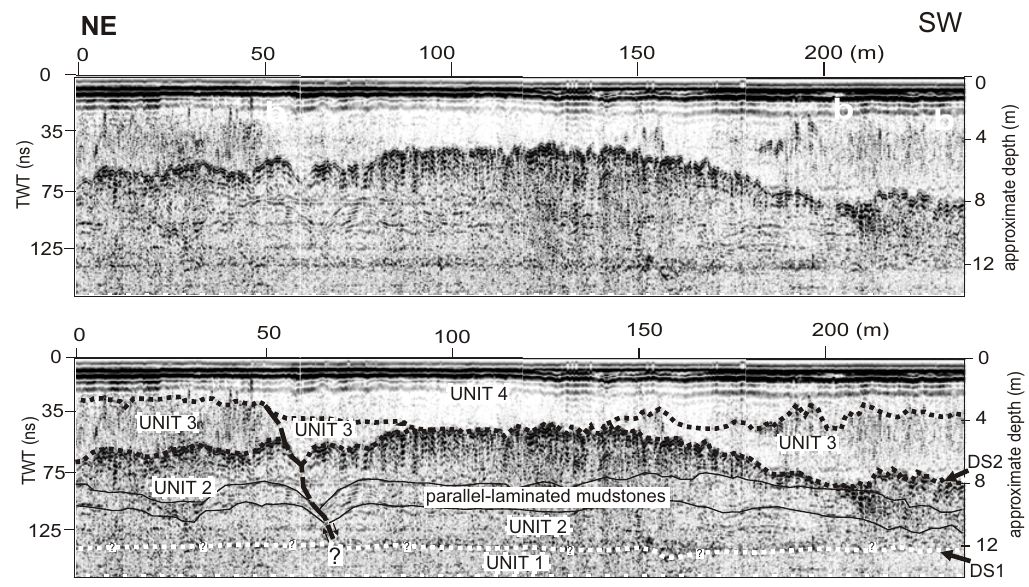
Fig. 4 – Non-annotated (upper) and annotated (lower) GPR section from the Outeiro Island area, illustrating four stratigraphic units (units 1 to 4) bounded by unconformities (hatched lines) that are locally displaced by a steeply-dipping normal fault (inclined black line). Note the drag of parallel reflections attributed to laminated mudstones from stratigraphic unit 2. Radar resolution does not allow determining the continuity of this fault down into unit 1, neither its upper boundary. The white dotted line indicates a trace that looks like ground water table, but outcrop data in the cliff face indicates this to match with a transgressive surface at the top of heterolithic deposits from unit 1. Units 1 and 2 = Miocene age (Barreiras Formation); Units 3 and 4 = Pliocene and younger (post-Barreiras sediments). See text for further